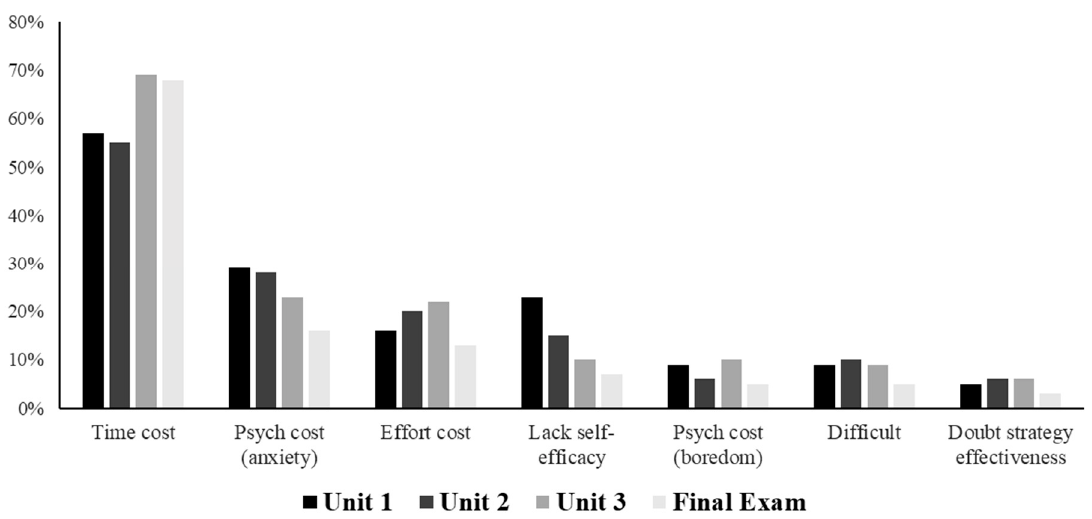
Figure 5. Percentage of reported barriers across unit exams.